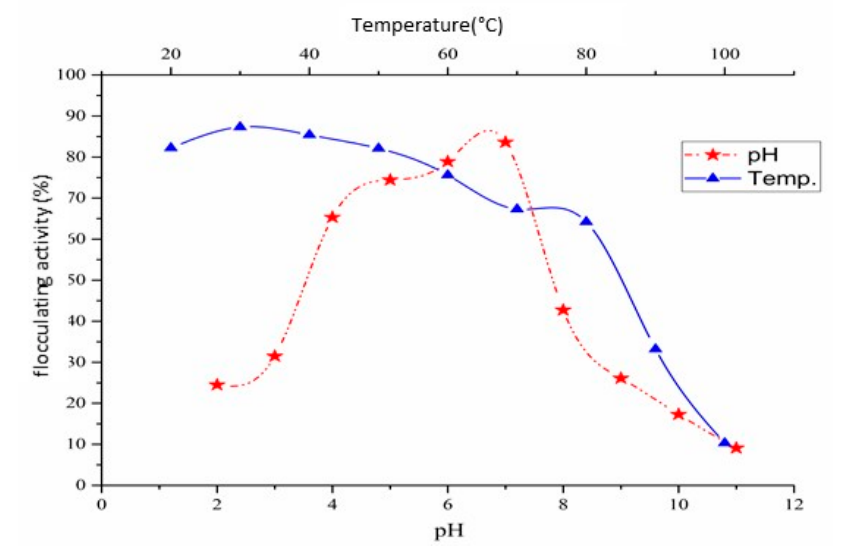
Figure 10. Thermal and pH stability of the purified QZ-7.